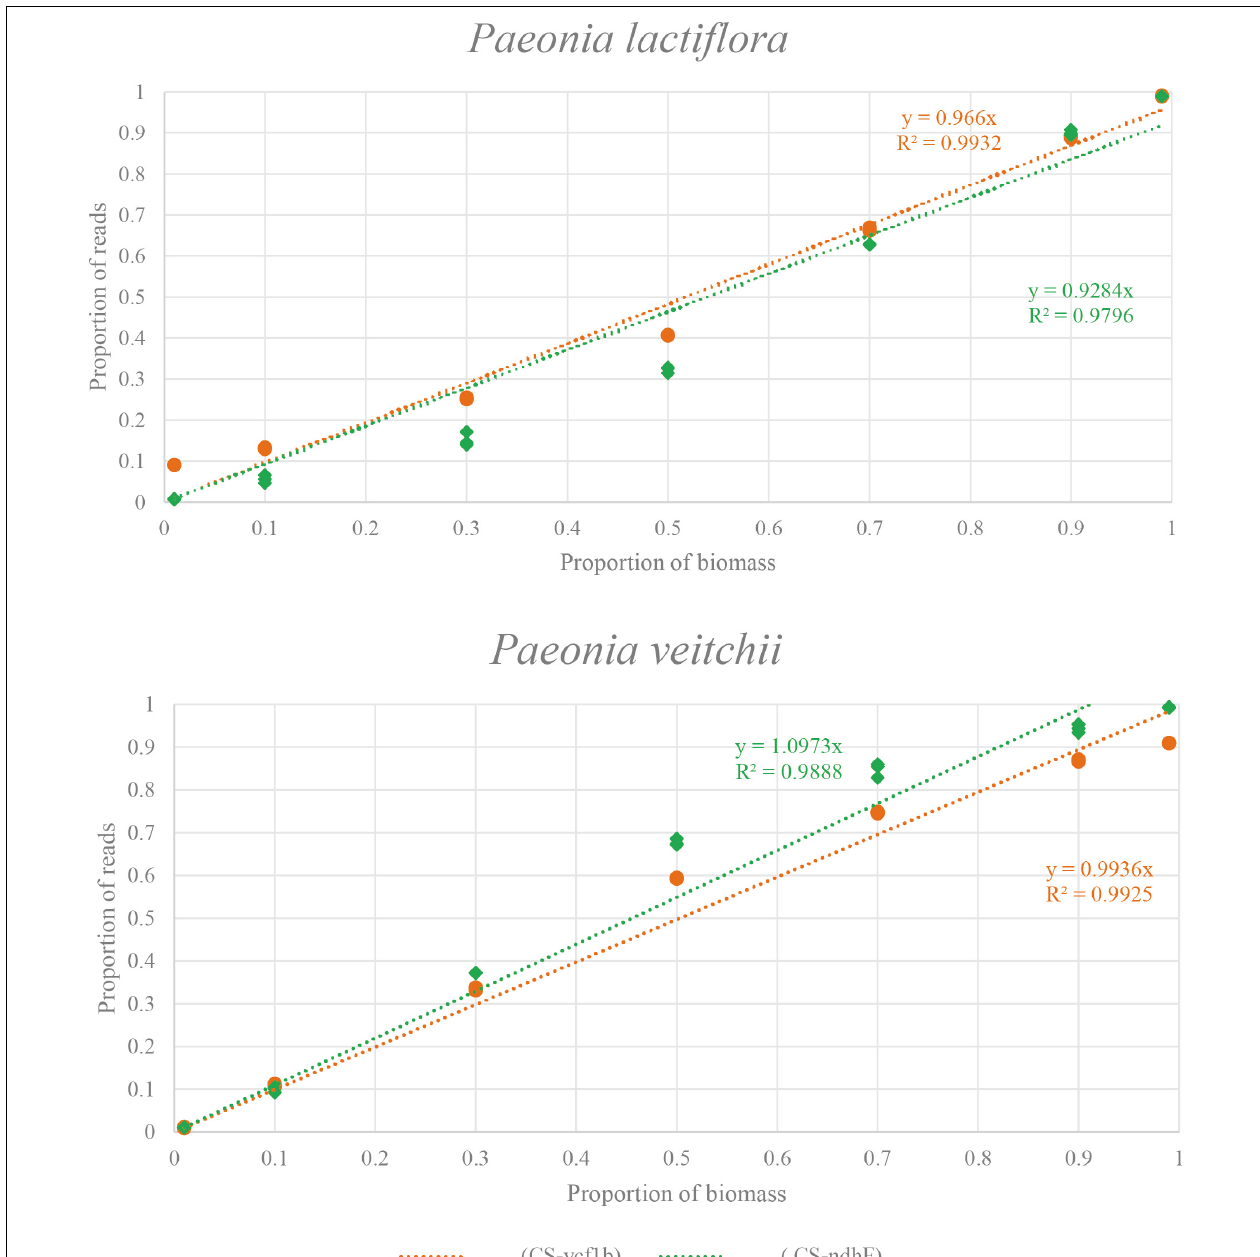
FIGURE 7 | The relationship between biomass and read counts of the products amplified by two primer pairs (CS -ycf1b and CS -ndhF ) in two species. X-axis, the proportion of biomass; Y-axis, the proportion of reads.